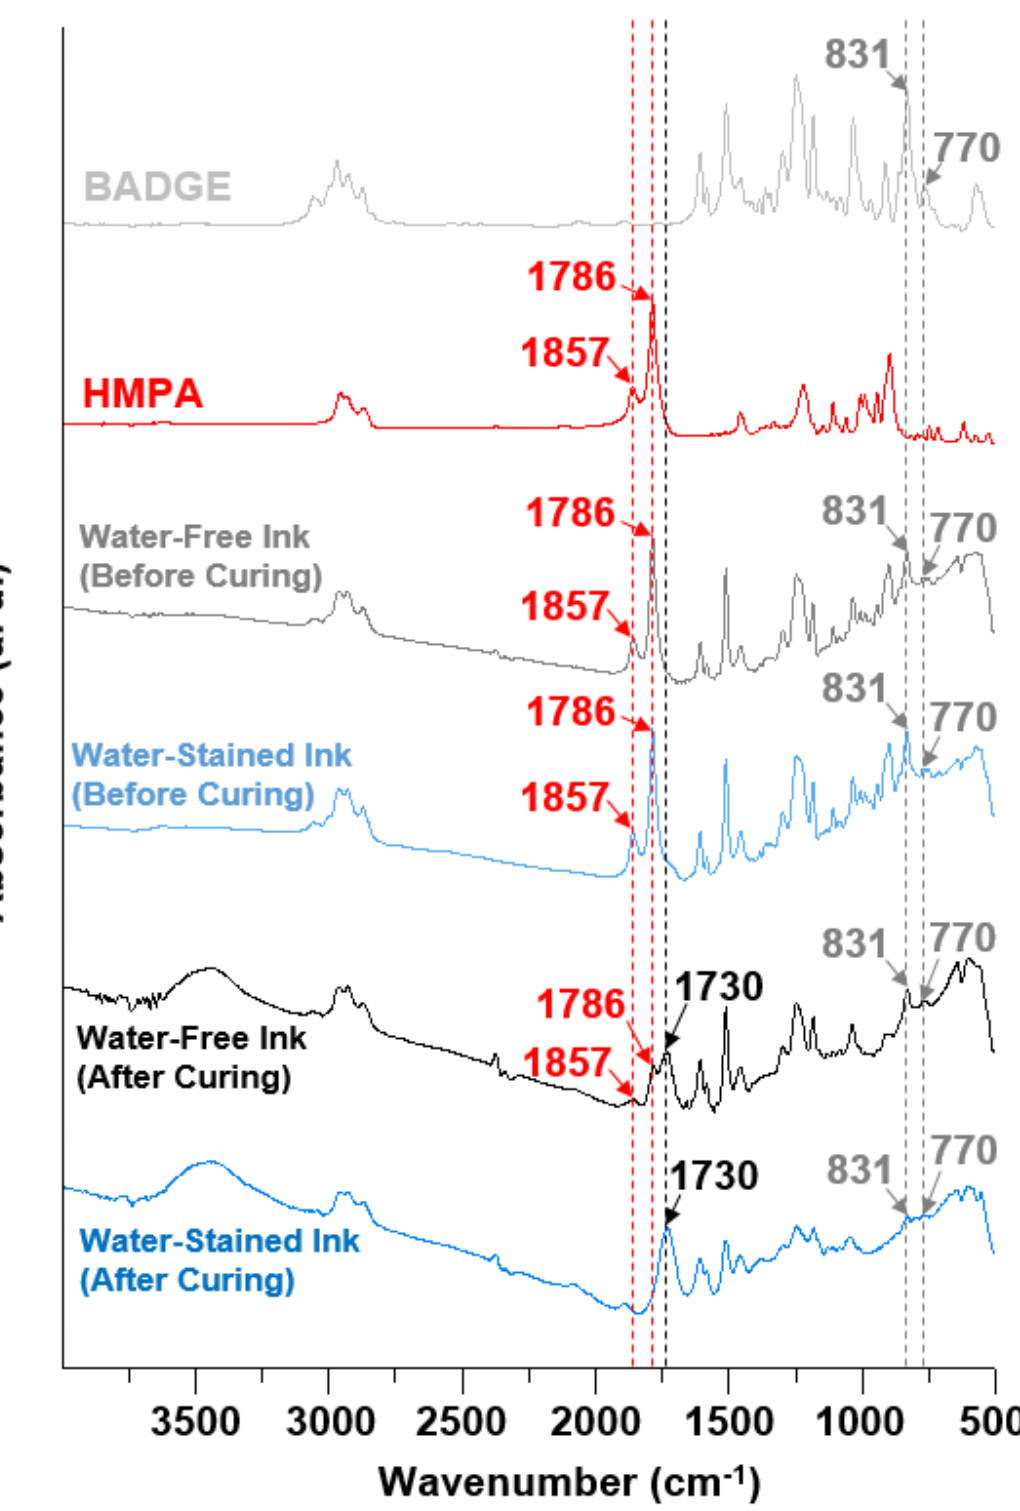
Figure 4. FTIR spectra for BADGE, HMPA, uncured epoxy − alumina inks without and with added water at 3 vol.%, and cured epoxy − alumina inks without and with added water at 3 vol.%. Fixed alumina concentration of 30 vol.% was used for all uncured and cured composite inks.